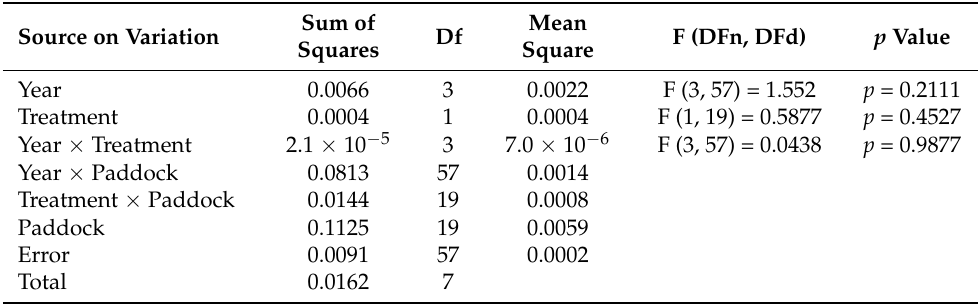
Table A2. Enhanced Vegetation Index (EVI) two-way repeated measure ANOVA of natural grassland, 4 years before to intensification practice ( n = 20).